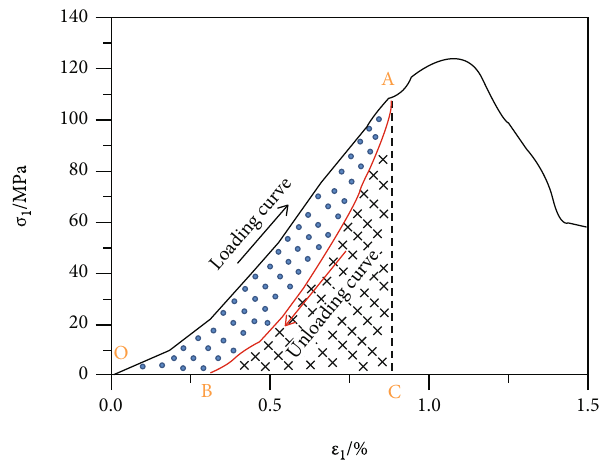
Figure 9: Energy relationship during loading and unloading